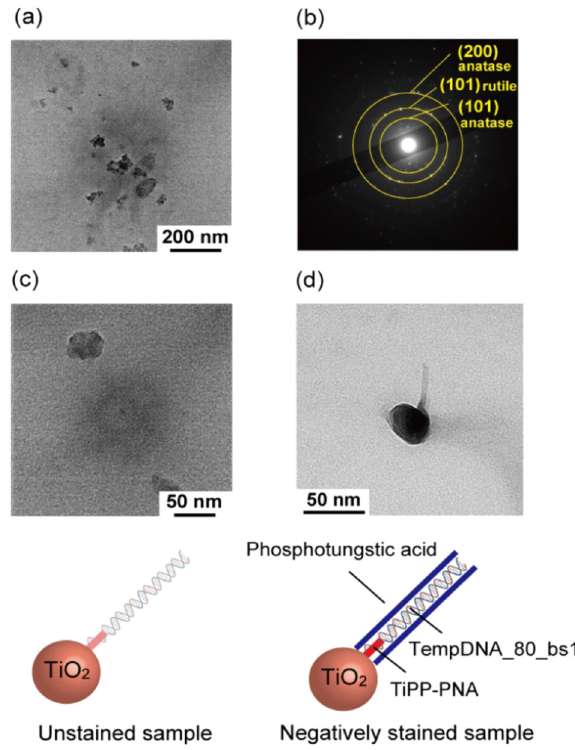
Fig. 4 Site-speci fi c precipitation of titania on a DNA terminus. a TEM image of mineralized titania after calcination at 700 °C . b SAED pattern of mineralized titania after calcination at 700 °C. TEM images of the sample after titania precipitation using TiPP-PNA and TempDNA_80_bs1. The TEM sample for ( c ) was not stained. The TEM sample for ( d ) was negatively stained with 2% phosphotungstic